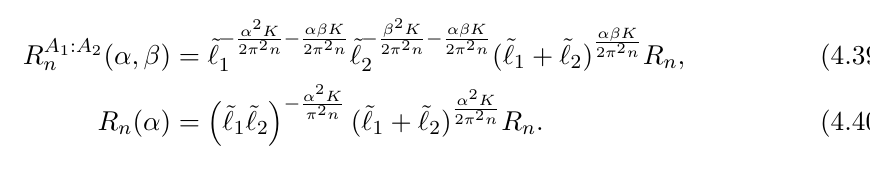
Figure 3 . Plots for the multi-charged moments. The continuous lines are plots of R A 1 : A 2 (given by using n = 1 in eq. (4.36) for the top two and bottom left plots and in eq. (4.39) for the bottom right plot) for K = 1 as a function of α at different values of β . The discrete points are the plots of the numerically evaluated multi-charged moments for the tight-binding model given in eq. (C.5). In the top plots, ‘ 1 = ‘ 2 and d is varied. In bottom left plot, ‘ 1 6 = ‘ 2 and the bottom right plot is for the adjacent interval case i.e. d = 0